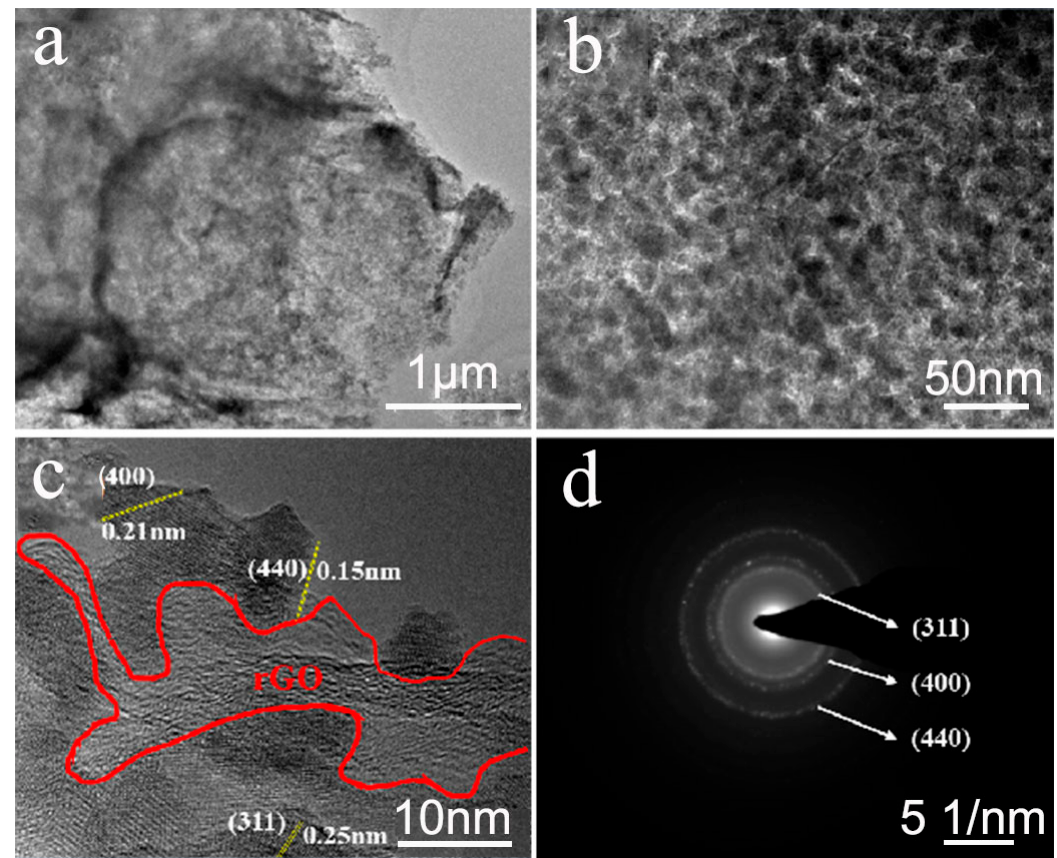
Figure 3. ( a ) The low-resolution and ( b , c ) high-resolution TEM images of rGO@CVO composite; ( d ) the SAED pattern of rGO@CVO composite.